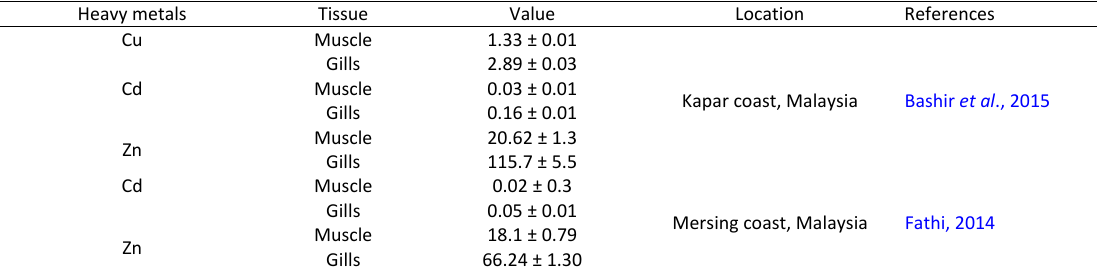
Table 4: Summary of recent literature on heavy metals in Pennahia Heavy metals